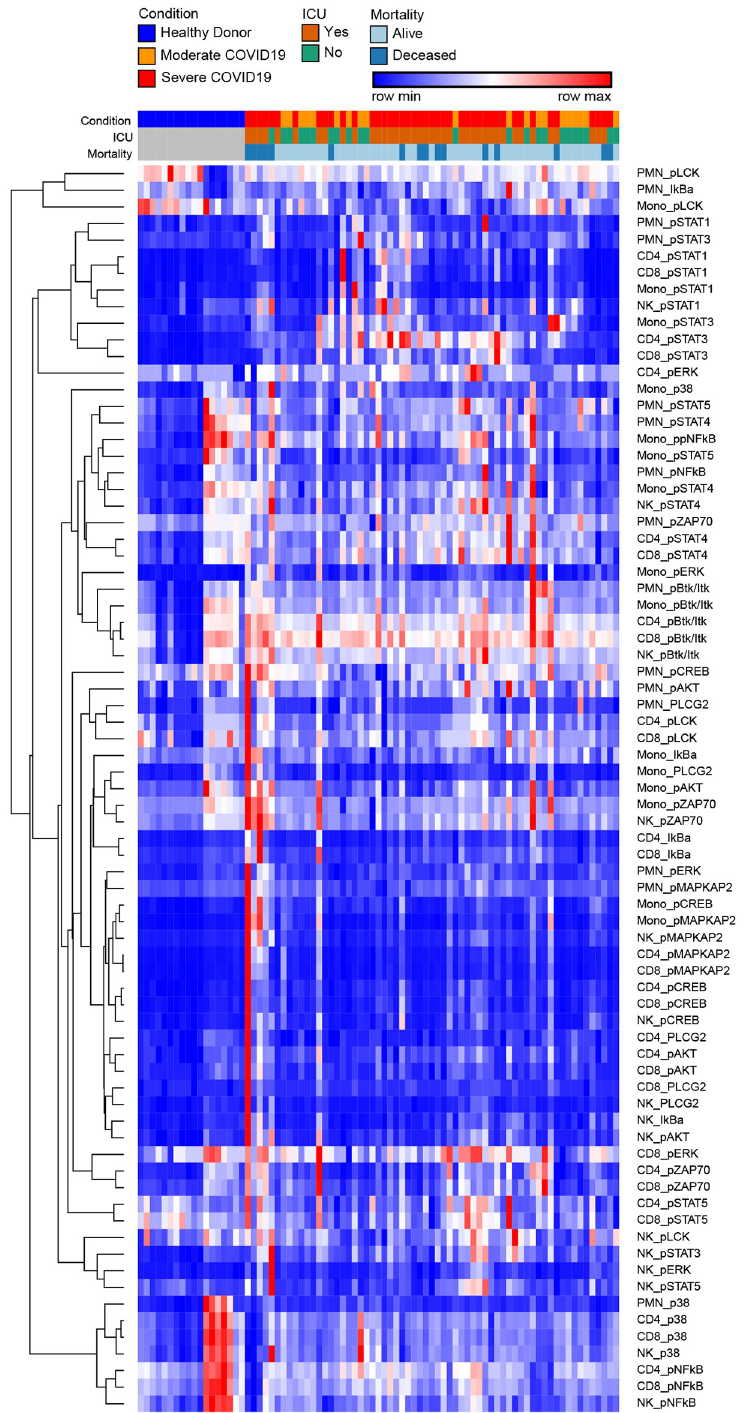
Fig 3. Heatmap of hierarchically clustered signaling phosphoprotein levels. Columns are individual samples and rows are cellular phosphoprotein features as labelled. Values are hierarchically clustered on columns and rows. Color values are normalized to row